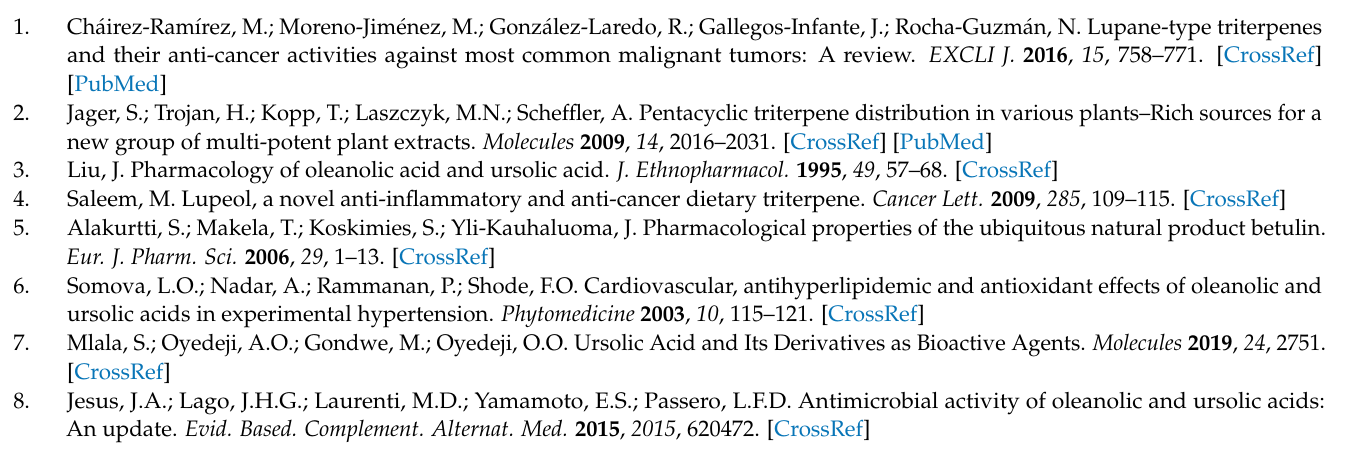
phase. Figure S1: SFC-APCI-MS chromatogram (SIM mode) of analytes model mixture (250 µ g · L –1 of each compound) obtained on various stationary phases. Figure S2: SFC-APCI-MS/MS